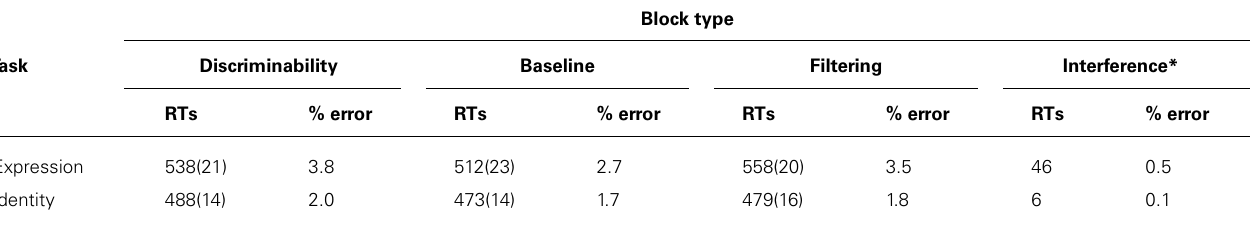
Table 1 | Mean reaction times (in milliseconds), standard errors (in parentheses), and percentages of error of performance in both identity- and expression-judgment tasks during discriminability assessment and interference measurements of Experiment